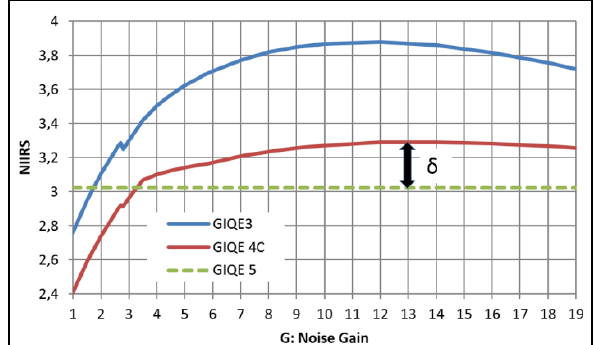
Figure 6: As Figure 4 with continuous form of GIQE